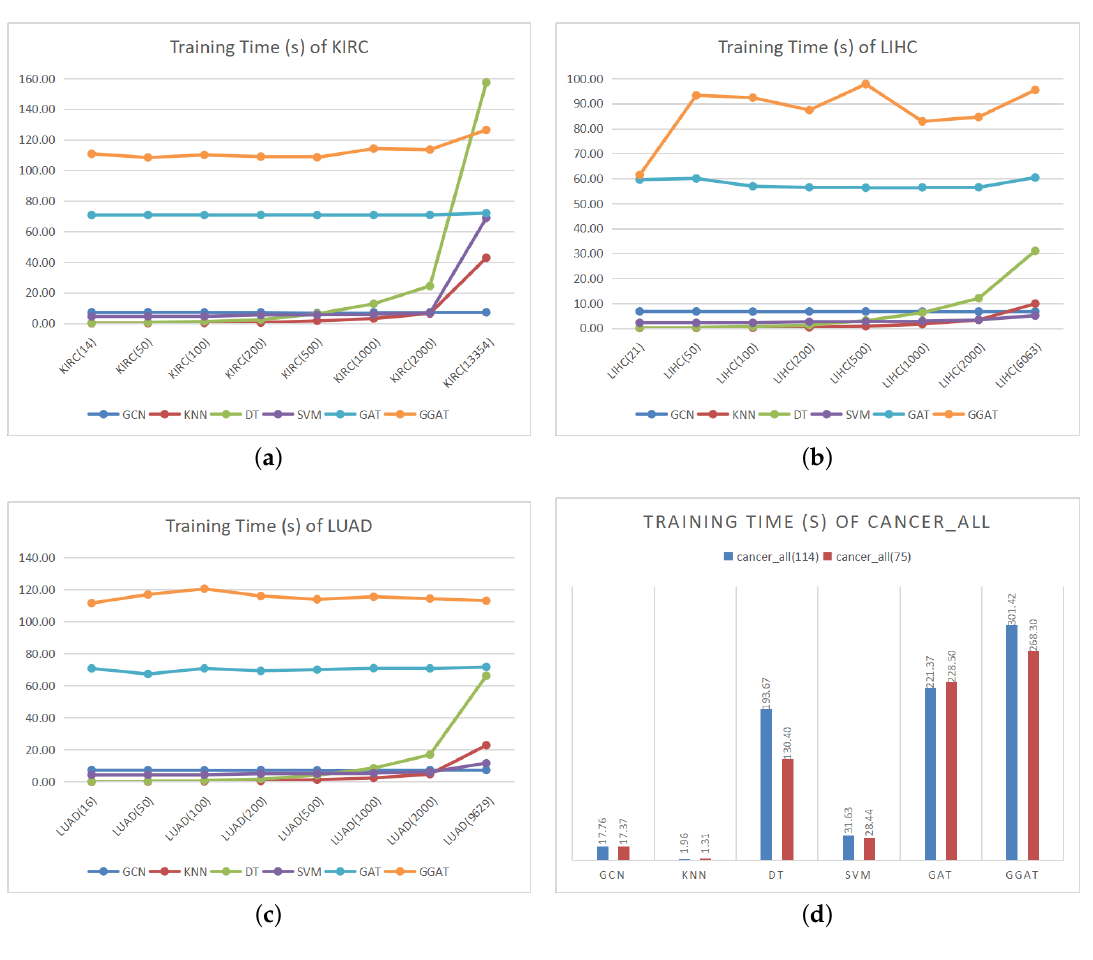
Figure 3. Training Time (s) of